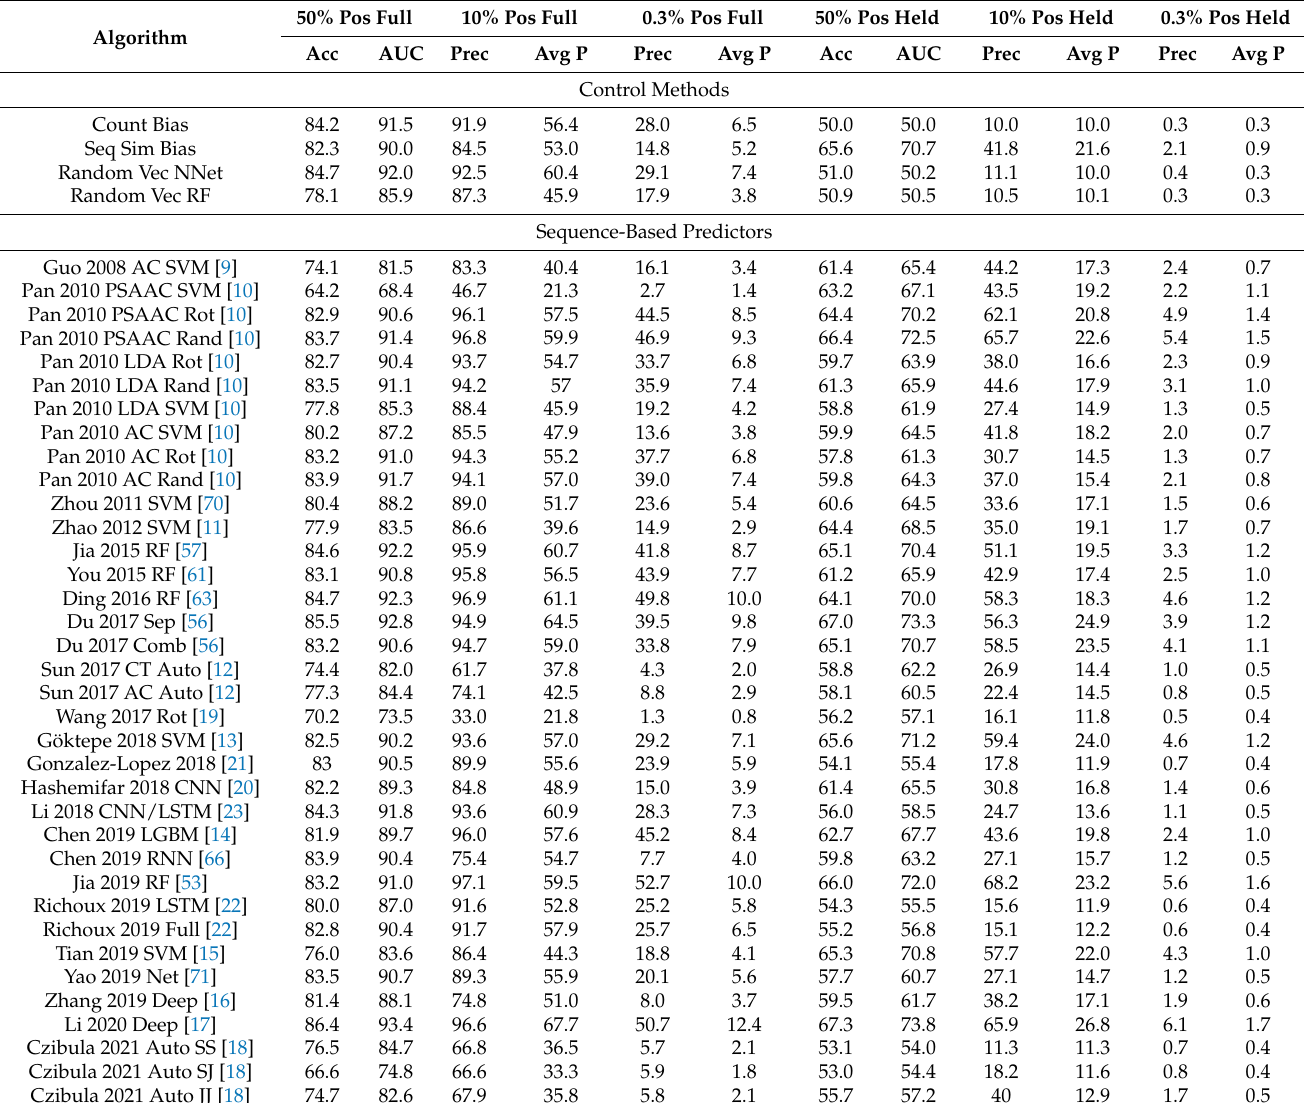
Table 6. Accuracies, Area Under the Receiver Operating Curve, Precision, and Average Precisions across all sequence based and illogical feature-based models and all